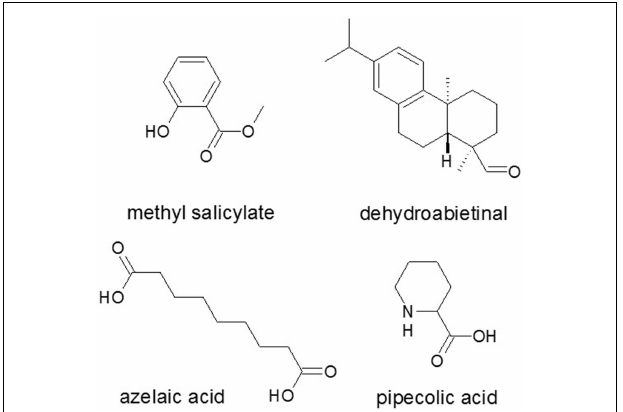
FIGURE 6 | Small metabolites as effectors in SAR signaling. Methyl salicylate, the abietane diterpenoid dehydroabietinal, pipecolic acid from lysine catabolism, and the dicarboxylic acid azelaic acid are effectors in SAR signaling additionally to SA. Source: National Center for Biotechnology Information. PubChem Compound Database (accessed Jun. 6, 2015) ( Bolton et al., 2008).